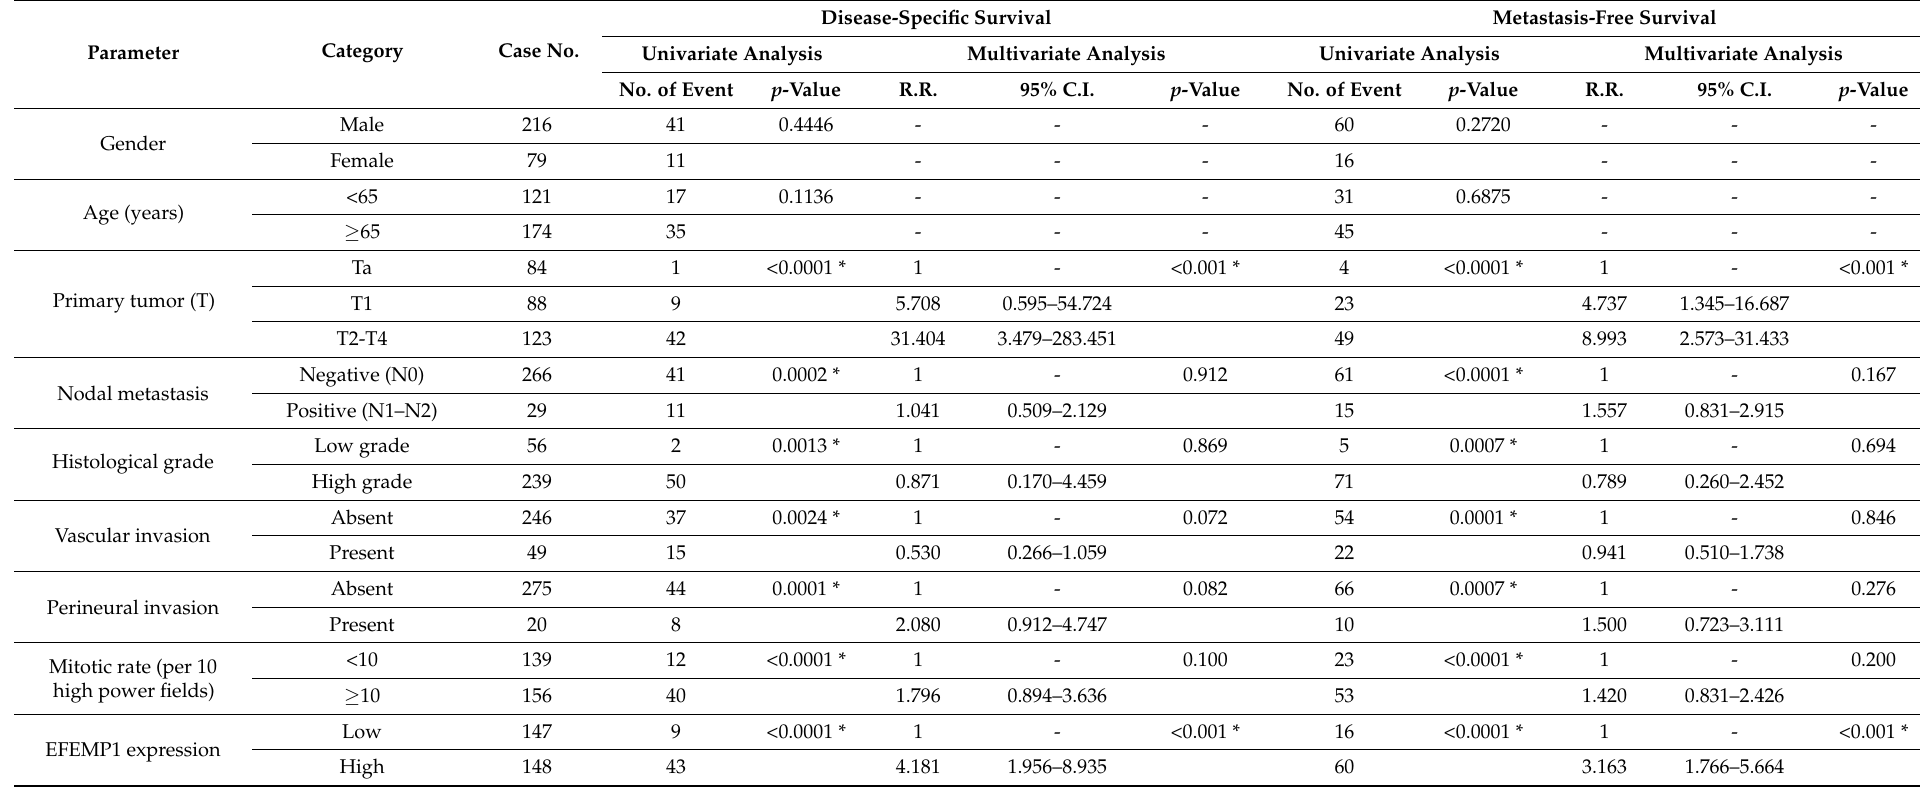
Table 4. Univariate log-rank and multivariate analyses for disease-specific and metastasis-free survivals in urinary bladder urothelial